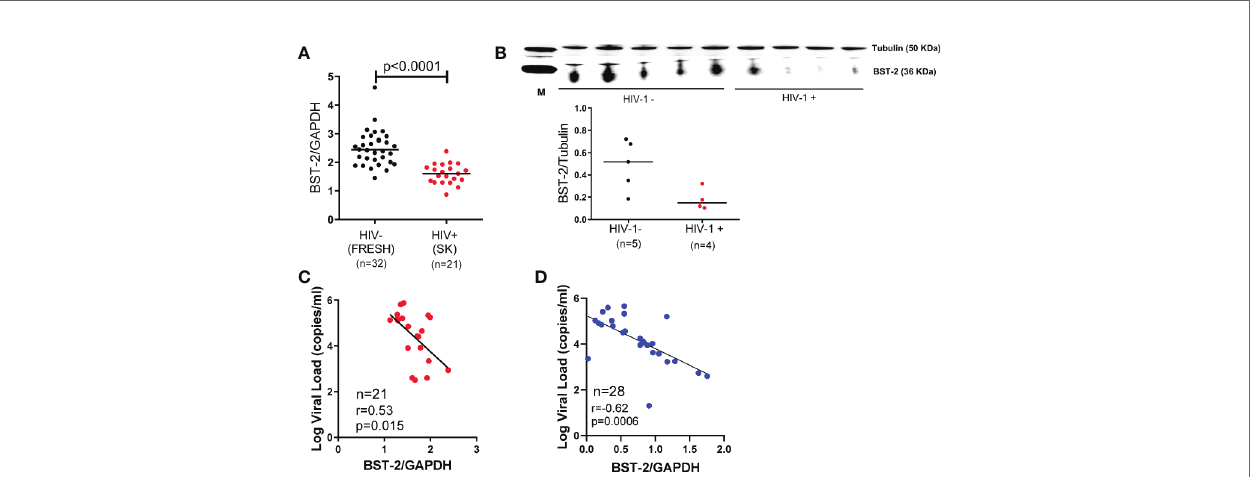
FIGURE 1 | BST-2 mRNA and protein expression levels within HIV-negative and positive individuals. (A) Comparison of BST-2 mRNA expression levels measured in HIV negative and positive donors from the FRESH, (black dots), and SK, (red dots) cohorts, respectively. Signi fi cantly elevated BST-2 levels are found within HIV negative donors vs. positives (p<0.0001). These represent unmatched donors from two separate cohorts. The HIV positive donors are ARV naïve chronically infected. (B) Protein levels of BST- 2 were measured on 5 HIV negative donors and 4 HIV infected donors from the FRESH and SK cohorts, respectively. BST-2 protein levels were assessed using a Western blot assay. The levels of HIV infected donors are lower than the HIV negative. (C) BST-2 mRNA expression levels were correlated with log viral load within the SK cohort. Higher mRNA levels correlated with lower log viral load levels (r=-0.53, p=0.0150). (D) A negative correlation was also observed when examining the effect of BST-2 mRNA expression levels and viral load using the CAPRISA 002 cohort at the >36 month time point (r=-0.62, p=0.0006).